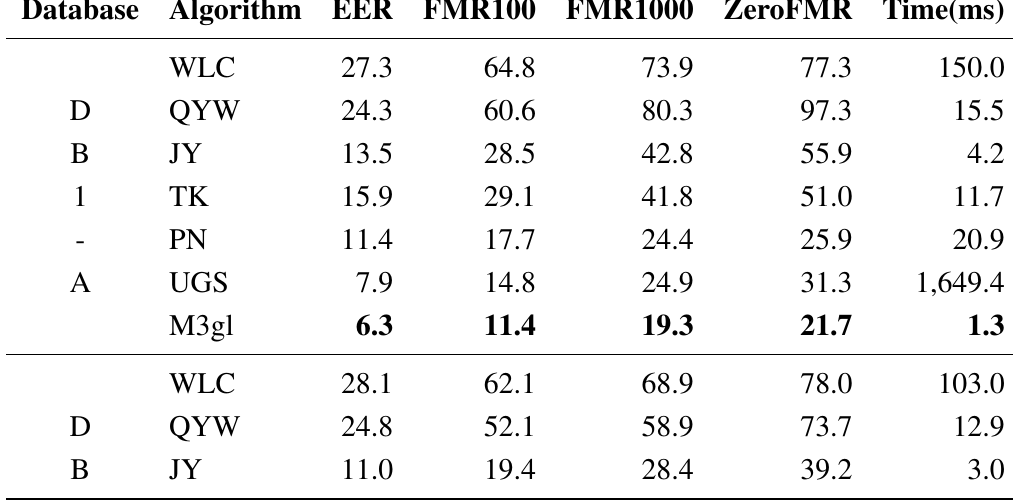
Experimental results on databases DB1 A, DB2 A, DB3 A and DB4 A of